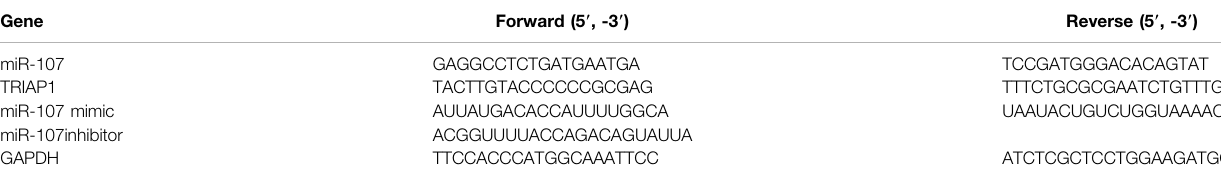
TABLE 1 | Primer sequence used in